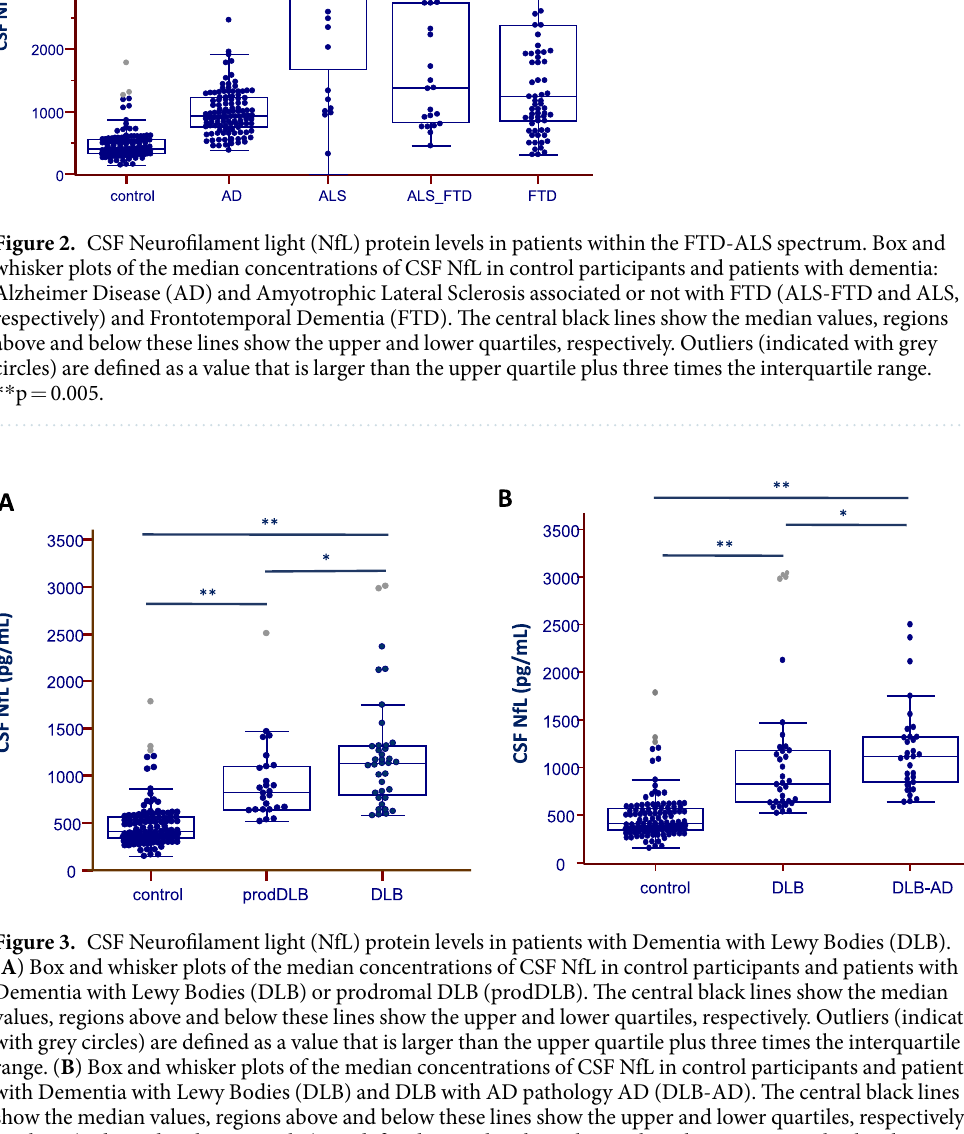
gradual increase in CSF NfL levels in these subgroups (p = 0.01), Fig. 3A, while the levels of the core AD biomark- ers (t-Tau, p-Tau and A β 1–42 ) were comparable (data not shown). The AUC for CSF NfL comparing prodDLB and DLB patients was 0.694 (95% CI 0.564–0.805). Compared to control subjects, CSF NfL was increased in prodDLB and DLB groups, Fig. 3A (p < 0.001), and the AUC was 0.875 (95% CI 0.806–0.927) comparing control and prodDLB subjects and 0.944 (95% CI 0.895–0.974), comparing control and DLB patients. CSF NfL levels were elevated in DLB patients with AD pathology (DLB-AD) compared to patients with pure DLB (p = 0.020), Fig. 3B. The AUC for NfL remained lower than the AUC for core AD biomarkers to discriminate these subgroups (data not shown).